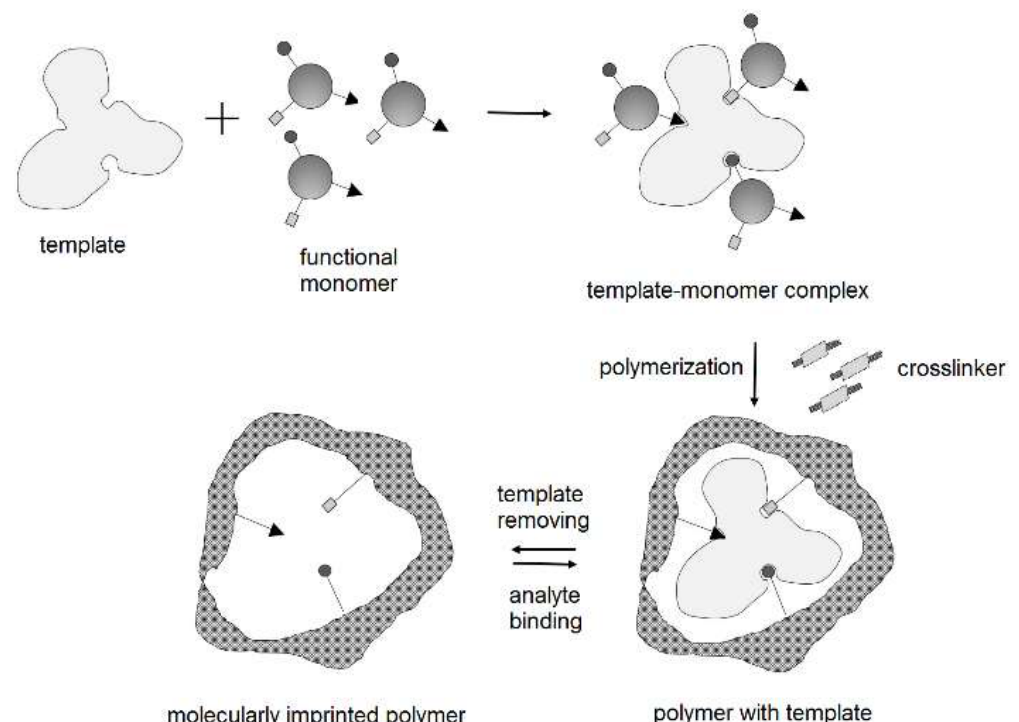
Figure 1. Scheme of MIP preparation [27].